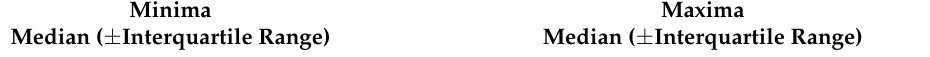
Table 4. Timing of minima and maxima. Values for head and withers expressed as percentage of left forelimb stance and values for pelvis expressed as a percentage of left hindlimb stance. Statistically significant differences between breeds are indicated separately for minima and maxima by pairs of values with the same letters (A–G), with level of significance indicated by asterisks (* p < 0.05, ** p < 0.01, *** p <